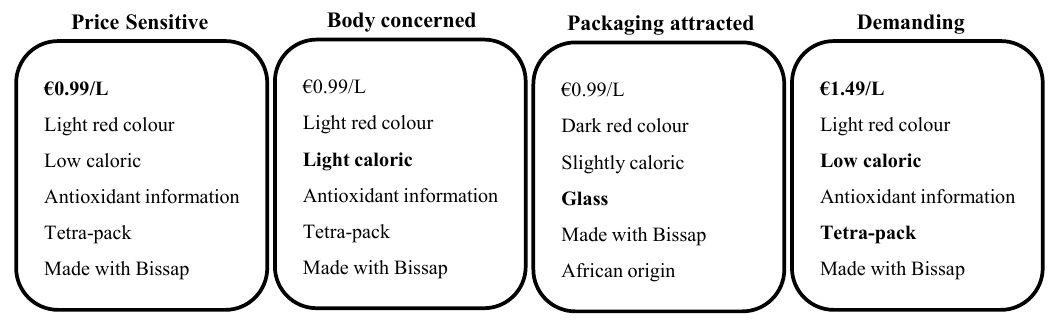
Figure 3. Optimal combination of attributes: ideal profile of Bissap beverage for each cluster.